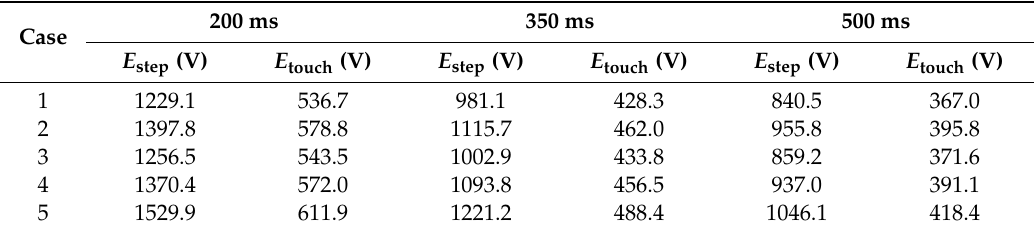
Table 5. Maximum permissible limits for step and touch voltages from the three-layer soil model.